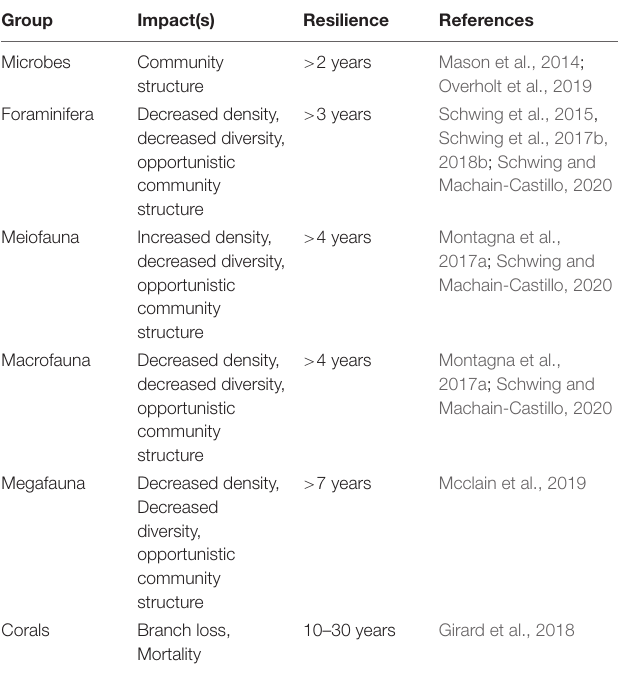
TABLE 1 | A summary of the impact type(s), resilience rates, and associated reference(s) for each group studied during and post-DWH. Group